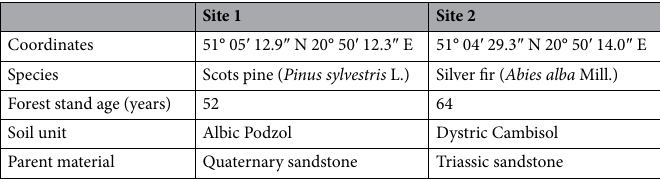
Table 1. Characteristics of the study